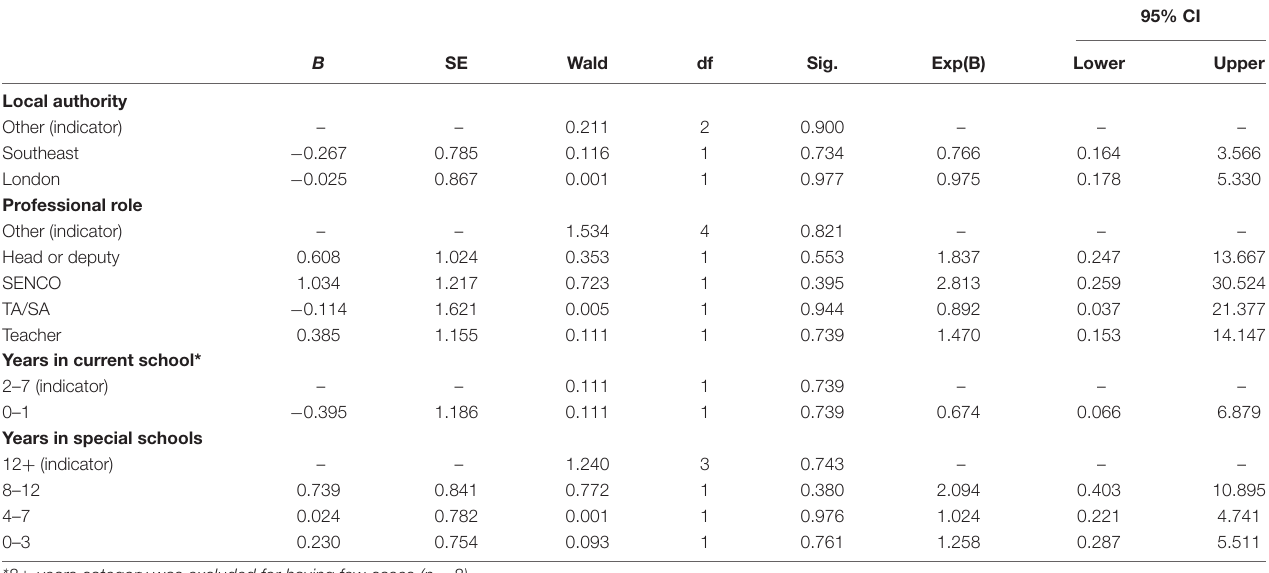
TABLE 2 | Regression coefficients regarding the effects of professional role, years of experience and geographical location of the setting on professionals’ perceived wellbeing (probability of responding that “it’s been hard or very hard”).